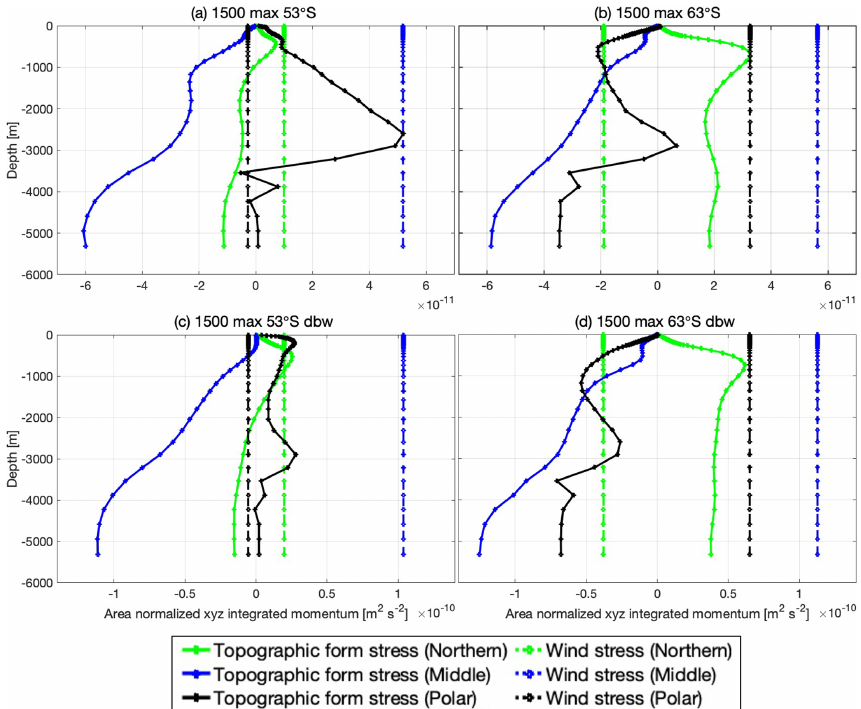
Figure 7. Area-normalised depth-integrated topographic form stress (solid curve) and wind stress integrated from the surface to various depths (dashed black line) in three channels (northern: 25–50 ◦ S, green; middle: 50–70 ◦ S, blue; polar: 70–83 ◦ S,